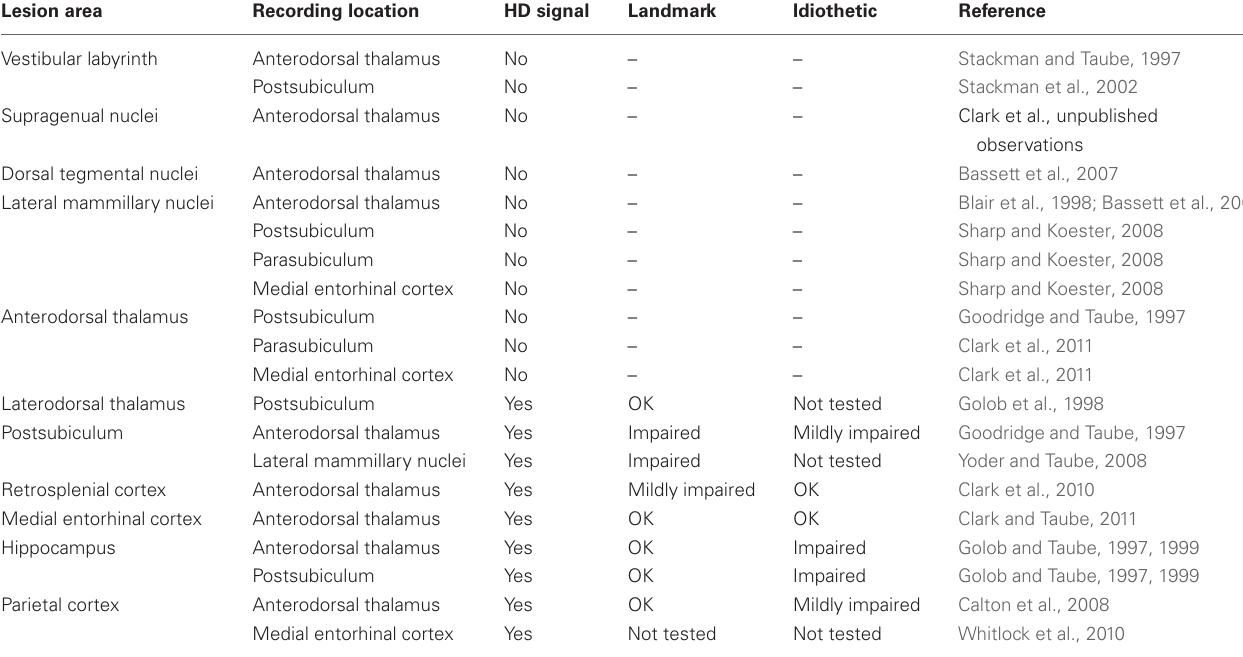
Table 1 | Summary of lesion results involving the HD cell